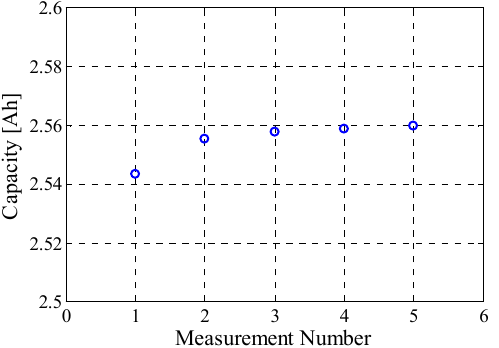
Figure 3. Discharging capacity of the LFP/C battery measured during the preconditioning test (1C- rate, T = 25 °C).